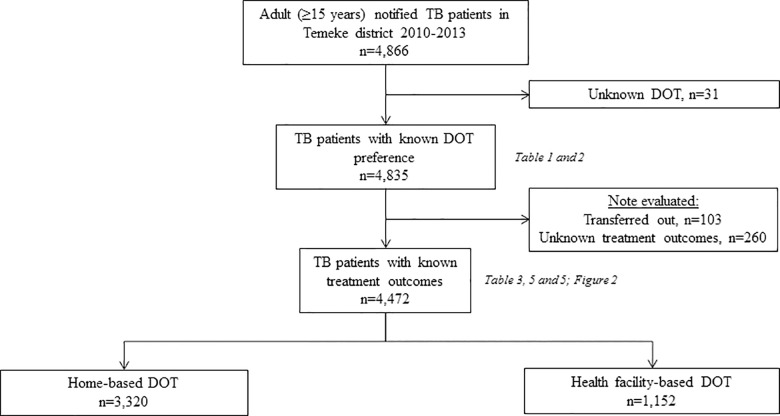
Selection of patients included in the study.